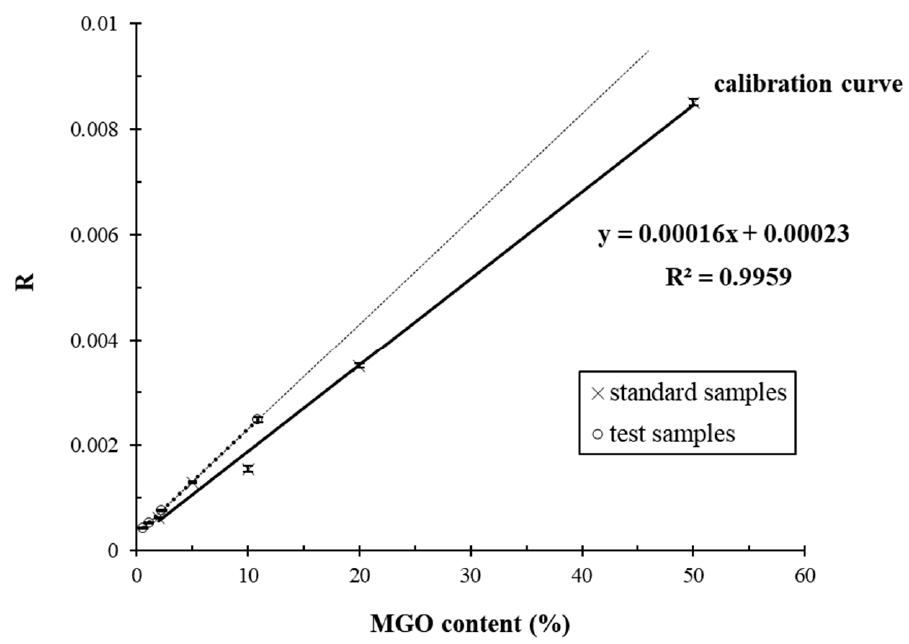
Figure 2. Comparison of the true and measured values ( R = diesel area/ n -decane area) of the marine gas oil (MGO) content in lubricating oil (LO).